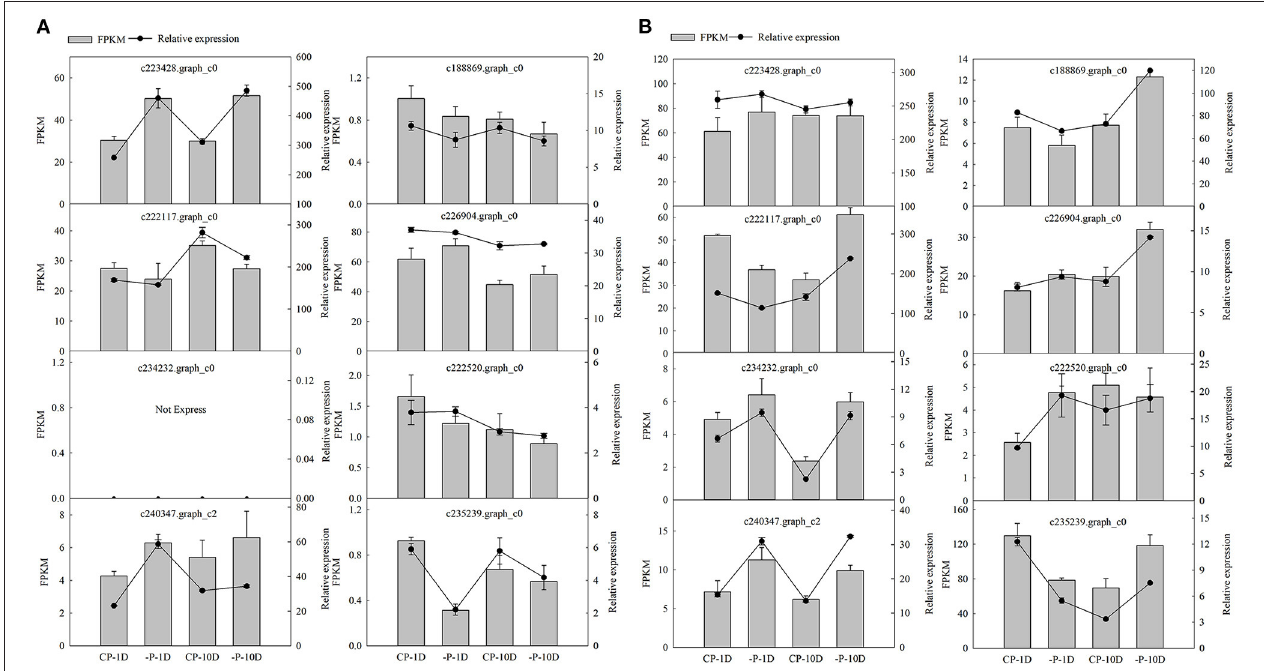
FIGURE 8 | Quantitative reverse-transcription PCR validation of DEGs in shoots and roots. (A,B) Represent expression levels of eight DEGs based on RNA-seq and qRT-PCR in the shoots and roots, respectively. Black columns represent FPKM based on the Illumina platform. Lines represent relative expression quantity tested by qRT-PCR. The bars represent SE ( n =